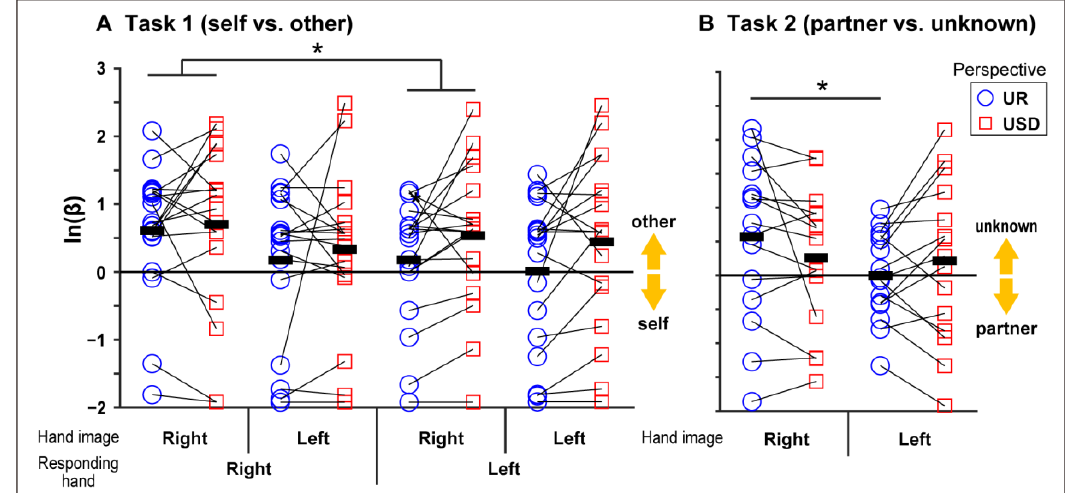
Figure 3. Mean ln(β) in ( A ) Task 1 (self vs. others) and ( B ) Task 2 (partner vs. unknown). UR and USD denote upright and upside-down images, respectively. Other main effects and interactions are described in the main text. Black bars indicate mean values in each condition. * p < 0.05.